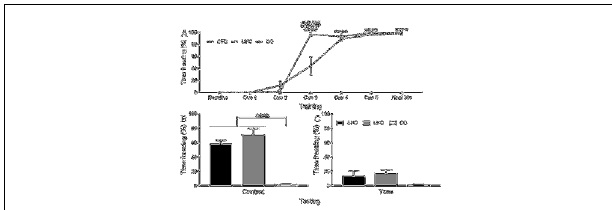
FIGURE 3 | Freezing to Context and Tone Data. (A) To obtain a progressive measure of fear learning, freezing behaviour was scored during training. Scoring was scored in the final 20 s of the first minute, the 20 s prior to each foot-shock, and the final 20 s of the final minute. Analyses revealed rats in the CO control to consistently have no fear-related freezing to context, whereas rats in the CFC and UFC groups progressively developed fear memories to context. As seen, by cue 3, rats in the CFC and UFC had significantly more fear-related freezing as compared to the CO control. Rats in the UFC also had significantly more fear-related freezing to context as compared to the CFC group. However, by cue 4, cue 5 and final 20 s, this had equalized, with both CFC and UFC groups have equivalent levels of freezing behaviour, which was significantly higher than that in rats in the CO control group. Asterisks denote level of statistical significance between both CFC and UFC vs. the CO control **** p ≤ 0.0001. Hash symbol denote level of statistical significance between the UFC and CO control group #### p ≤ 0.0001. (B) Two weeks following conditioning, rodents were re-exposed to context A, and a FMT was conducted. As seen, rats in both the CFC and UFC groups froze significantly more than rats in the CO control group. (C) To ensure that no additional fear to tone developed in rats in the UFC, 3 days following the first FMT, all rats were exposed to the new context B and provided with auditory tones. Statistical analyses revealed no statistically significant increases in either of the fear-conditioned groups. CFC, contextual fear conditioning; UFC,